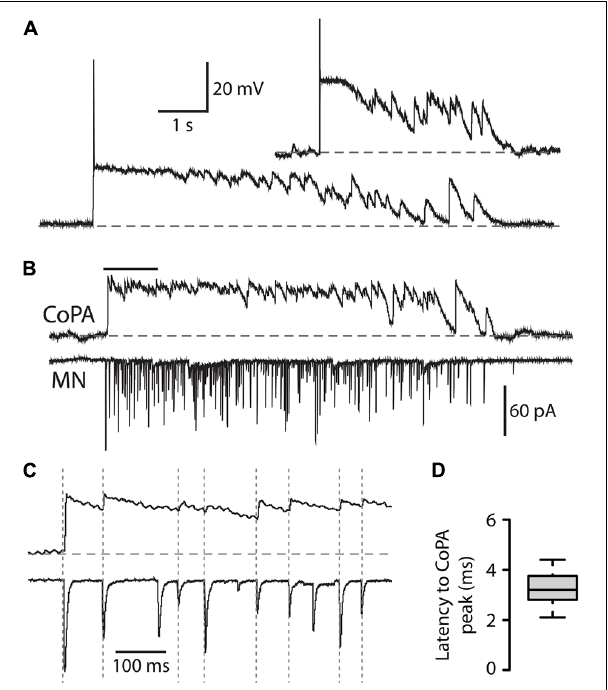
FIGURE 6 | Commissural primary ascending interneurons receive rhythmic inhibition in phase with excitation to ipsilateral MNs during burst swimming episodes. (A) Two examples of activity patterns in CoPAs from embryos at 27–29 hpf that have longer durations than fictive coiling events and whose durations resemble those of bouts of immature swimming at this age. (B) Example of a simultaneous whole-cell recording from a 29 hpf embryo of activity in a CoPA (in current clamp) and an ipsilateral motoneuron (in voltage-clamp) during a spontaneous bout of fictive burst swimming. Scale for CoPA trace same as for (A) , vertical scale shown for MN trace. (C) Ten times horizontally expanded view of the burst from the indicated region in (B). Dotted vertical lines indicate local maxima (peaks) in the CoPA trace that correlate with MN peaks. (D) Quantification of the latency between peaks in the CoPA trace relative to peaks in the MN trace. N = 20 peaks from one